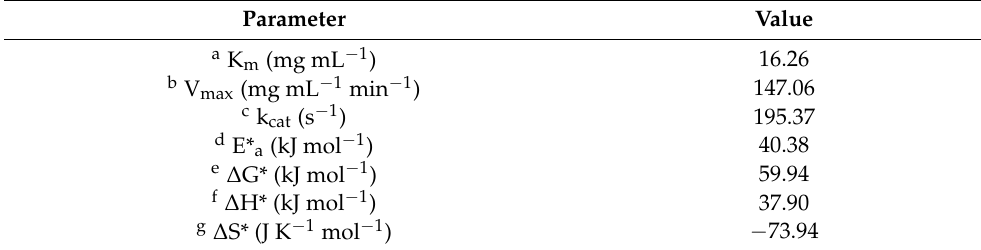
Figure 3. ( A ) Lineweaver-Burk plot to calculate K m and V max of Aspergillus tamarii URM4634 protease produced by sequential fermentation using azocasein as a substrate (R 2 = 0.993), and ( B ) Arrhenius-type plot (on the right) to estimate the activation energy of the azocasein hydrolysis reaction (R 2 = 0.998). Table 5. Kinetic and thermodynamic parameters of the azocasein hydrolysis reaction catalyzed by the Aspergillus tamarii URM4634 protease produced by sequential fermentation using wheat bran as a substrate. 25 °C was selected as a reference temperature.